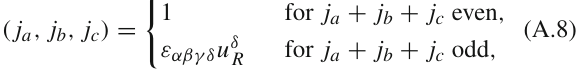
Table 7 Results of unbinned maximum likelihood fits for 100 pseudo- experiments, for simplified two-amplitude models generated with λ γ = 1, for various relative magnitudes and phases. The parameters a and φ stand respectively for the relative magnitude and phase between the decay with K 1 ( 1270 ) + → K + ρ( 770 ) 0 and the decay with